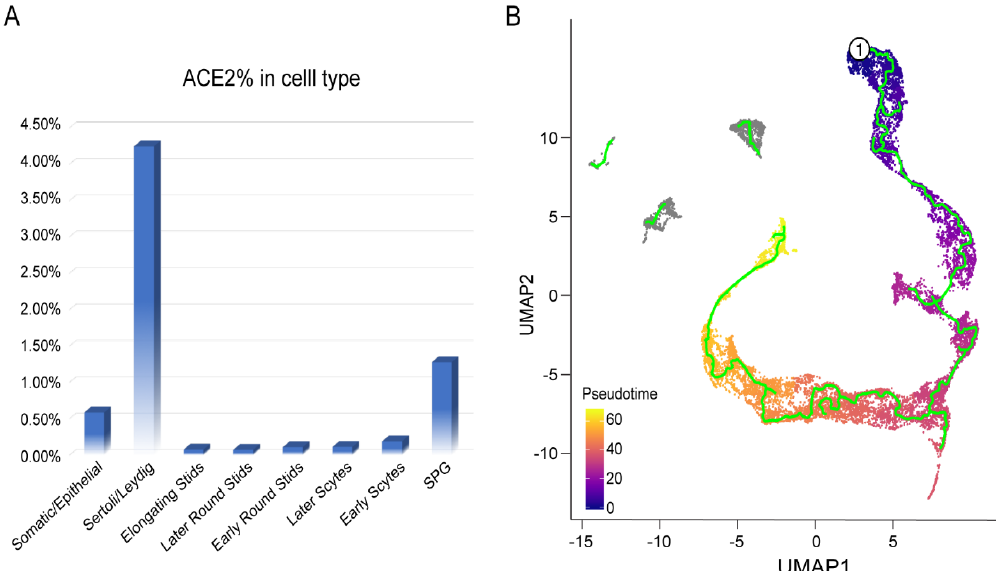
Figure 3. Composition of ACE2-positive cells and pseudotime analysis of human testicular cells. ( A ) ACE2-expression cells in each identified cell type. SPG—spermatogonia. ( B ) Trajectory of male germ cell development by pseudotime time analysis of human testicular cells.